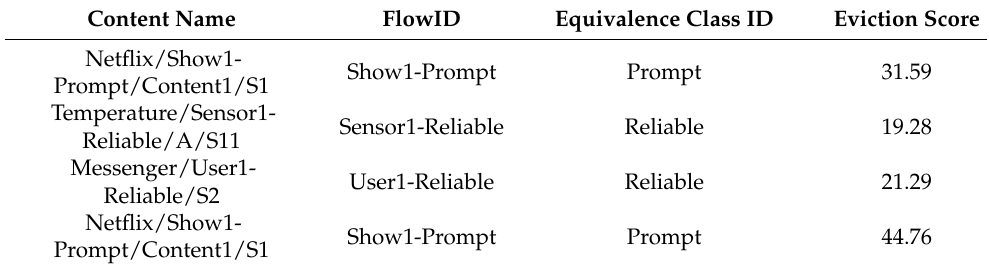
Table 3. Flow Table